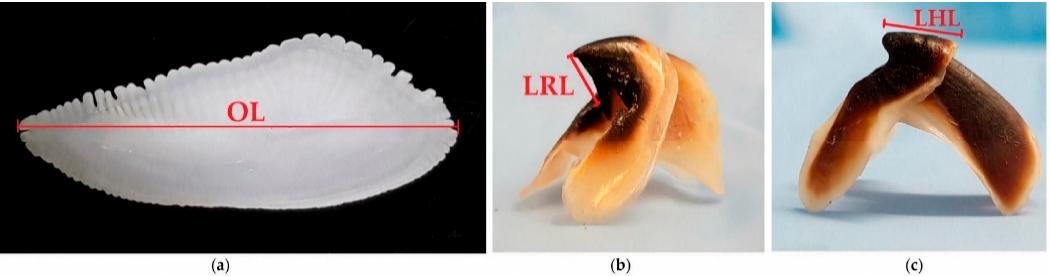
Figure 2. Images of otoliths and beaks, with relative measures: ( a ) major axis length (OL) of M. merluccius left otolith; ( b ) lower rostral length (LRL) of I. coindetii lower beak; ( c ) lower hood length (LHL) of O. vulgaris lower beak.